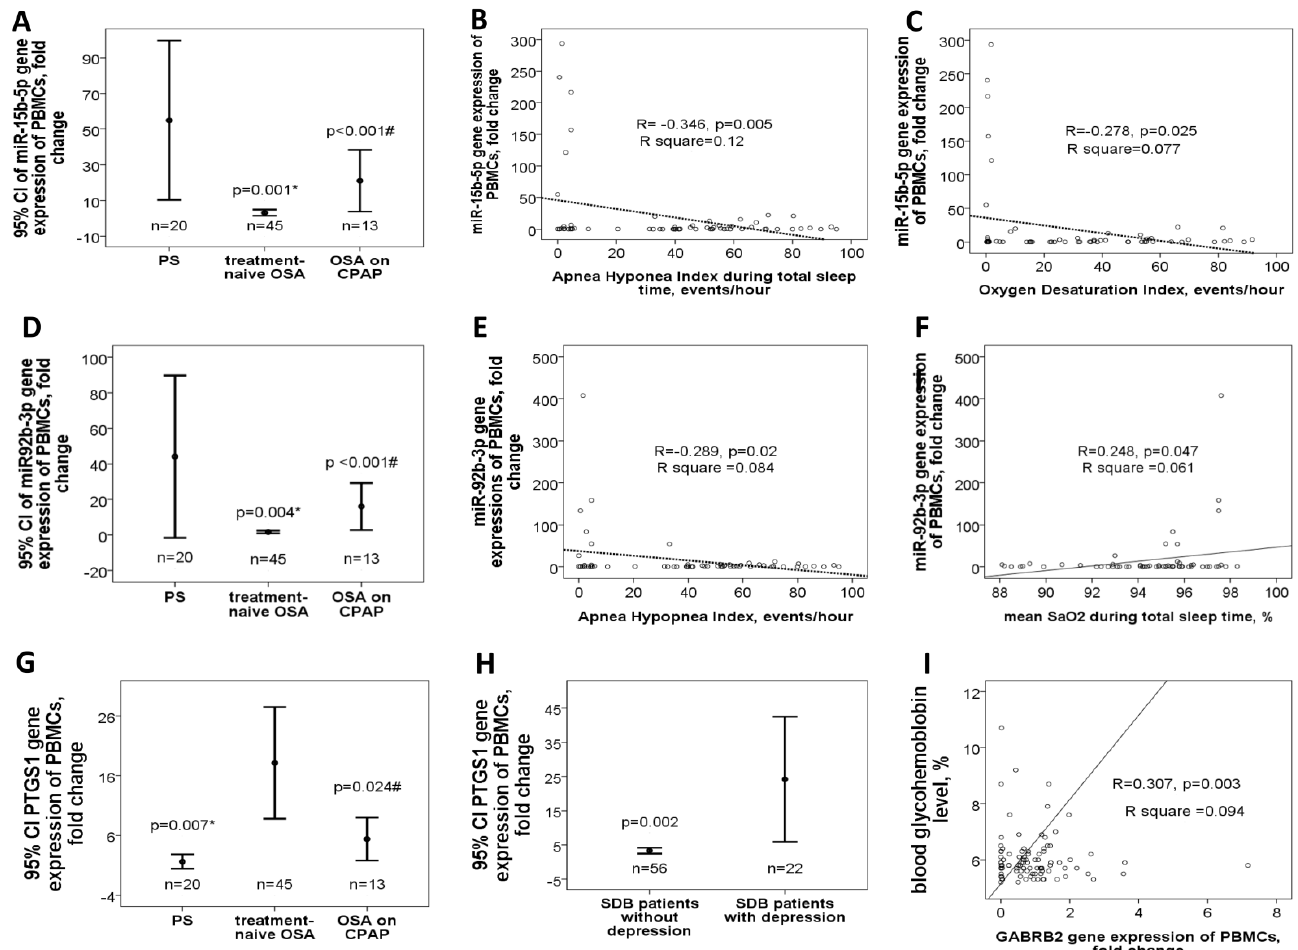
Figure 5. Down-regulated miR-15b-5p/miR-92b-3p genes and corresponding changes of their predicted target genes in the validation cohort. MiR-15b-5p gene expression was ( A ) decreased in treatment-naïve OSA patients versus either PS subjects or OSA patients on long-term CPAP treatment, and negatively correlated with ( B ) apnea hypopnea index (AHI) and ( C ) oxygen desaturation index. miR-92b-3p gene expression was ( D ) decreased in treatment-naïve OSA patients versus either PS subjects or OSA patients on long-term CPAP treatment, ( E ) negatively correlated with AHI, and ( F ) positively correlated with mean oxygen saturation (SaO2) during total sleep time. PTGS1 gene expression was ( G ) increased in treatment-naïve OSA patients, and ( H ) further increased in those with depression. ( I ) ADRB1 gene expression was negatively correlated with nadir SaO2.